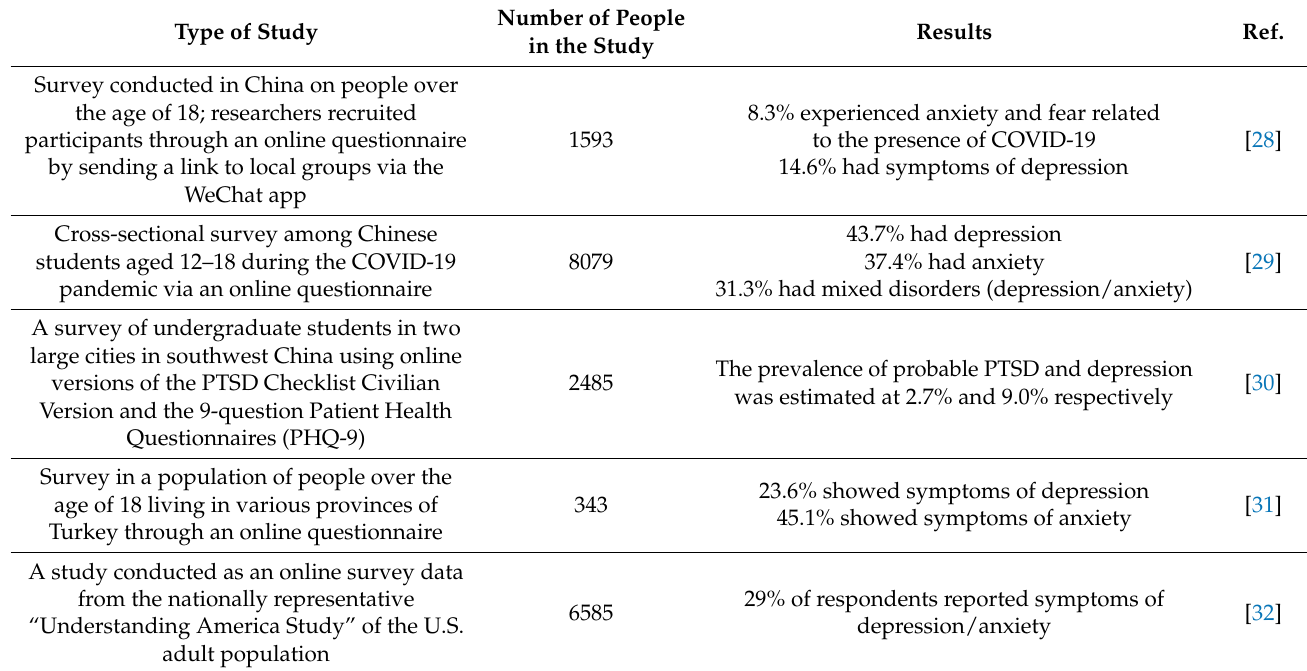
Table 1. Selected studies considering outcomes related to mental